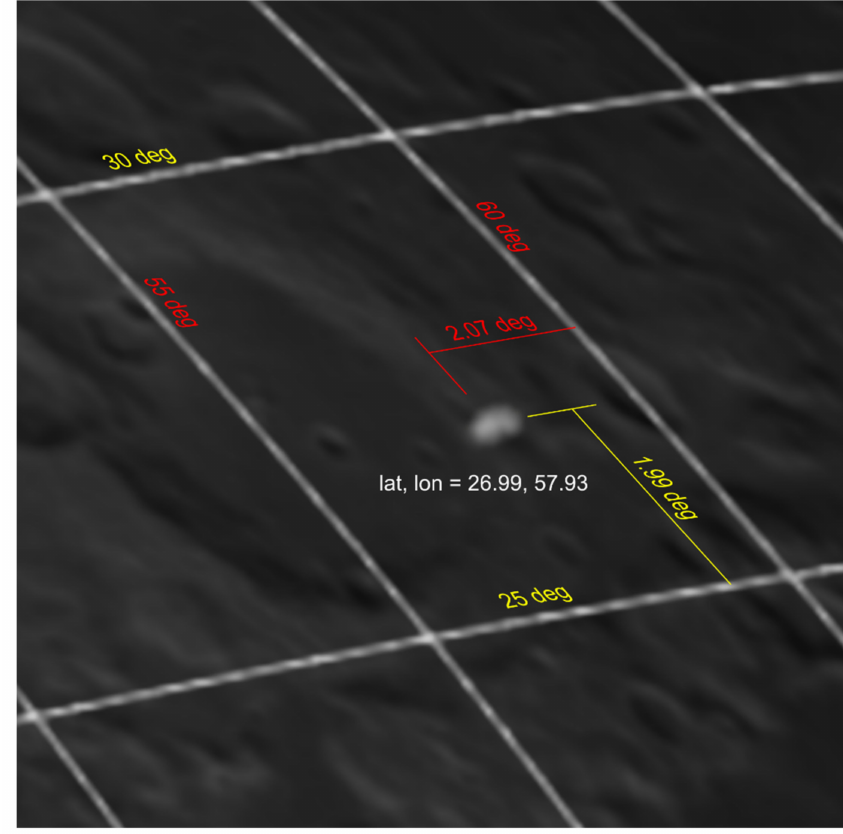
Figure 9. The location of the barycentre of Flash 2 in selenographic